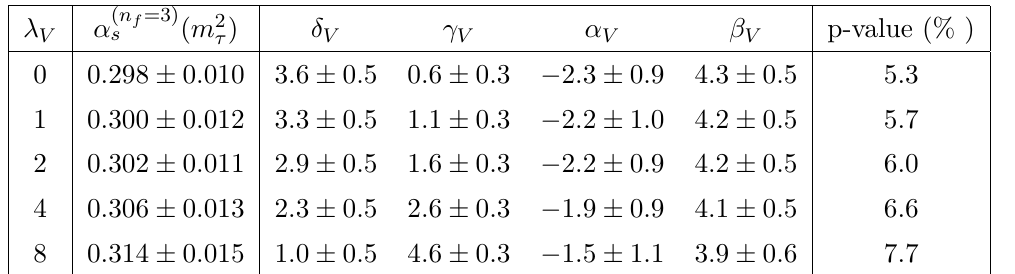
) , in FOPT, and the spectral ansatz parameters in eq. (4.2) τ [40]. V